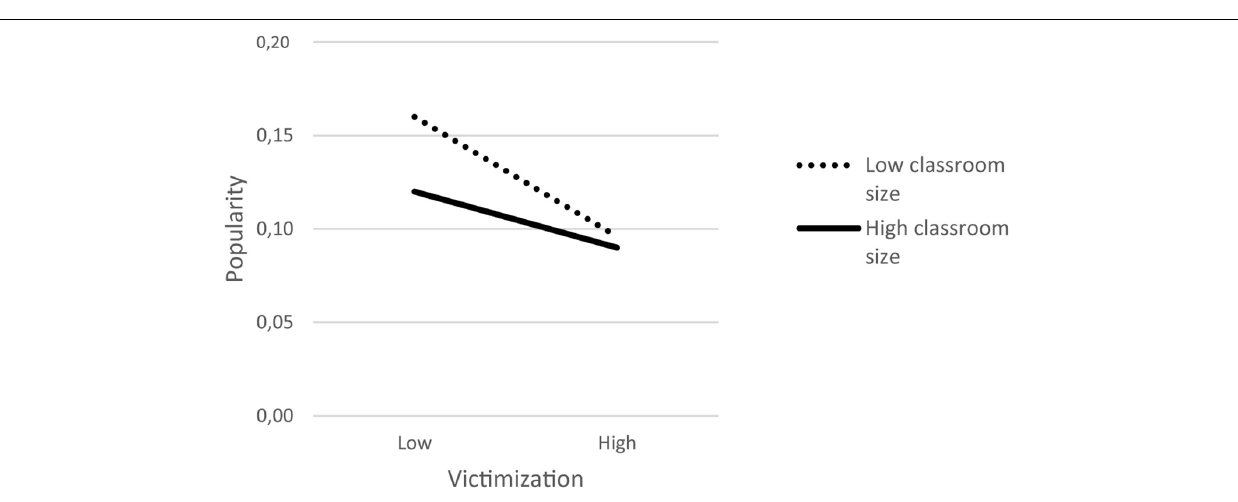
FIGURE 2 | Moderating effects of classroom size on the association between classroom mean-centered self-reported victimization and popularity in the Dutch sample. Cut-offs of 1SD above and below the mean were used to represent the level of popularity of adolescents high and low in victimization, in small classrooms ( ∼ 21 students) and in large classrooms ( ∼ 29